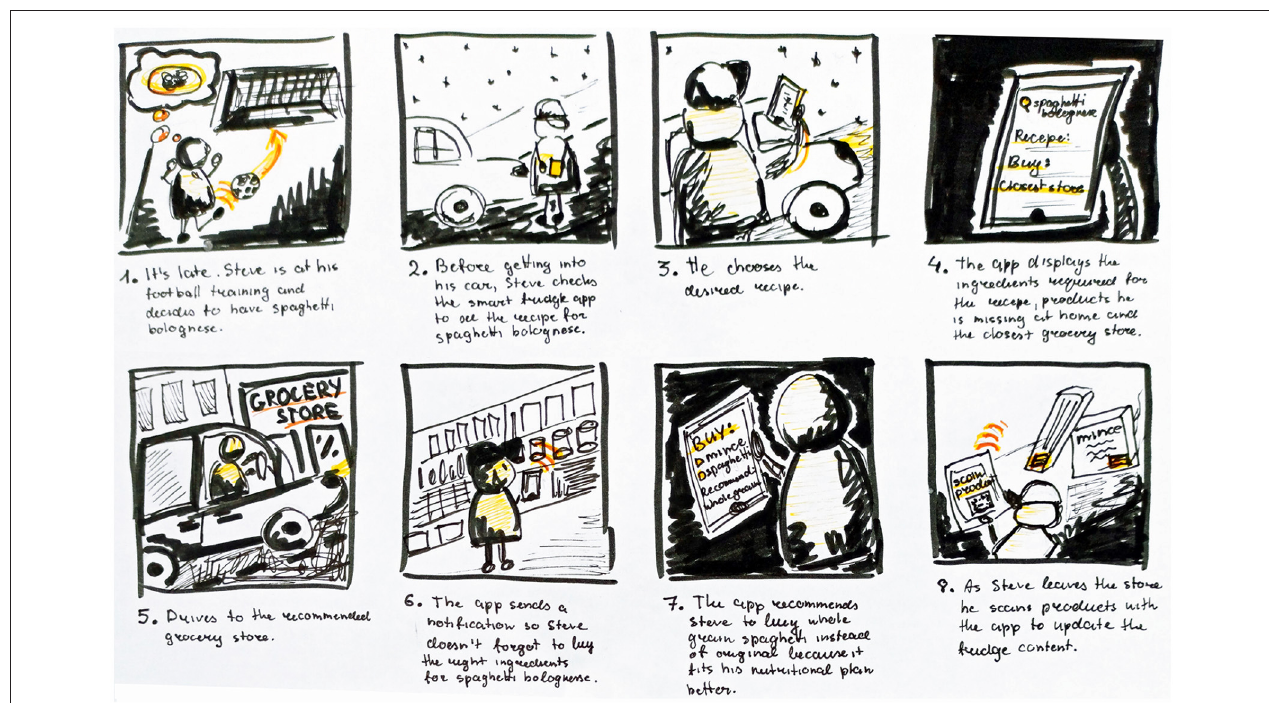
FIGURE 3 | Student storyboard for coursework component of 2nd year HCI, based on lecture and hands-on sketching session. Reproduced with permission Indre Aruodziute,